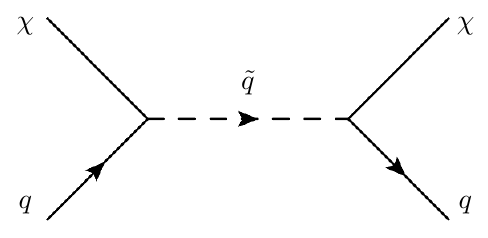
Figure 1 . Representative Feynman diagram for scattering between DM and